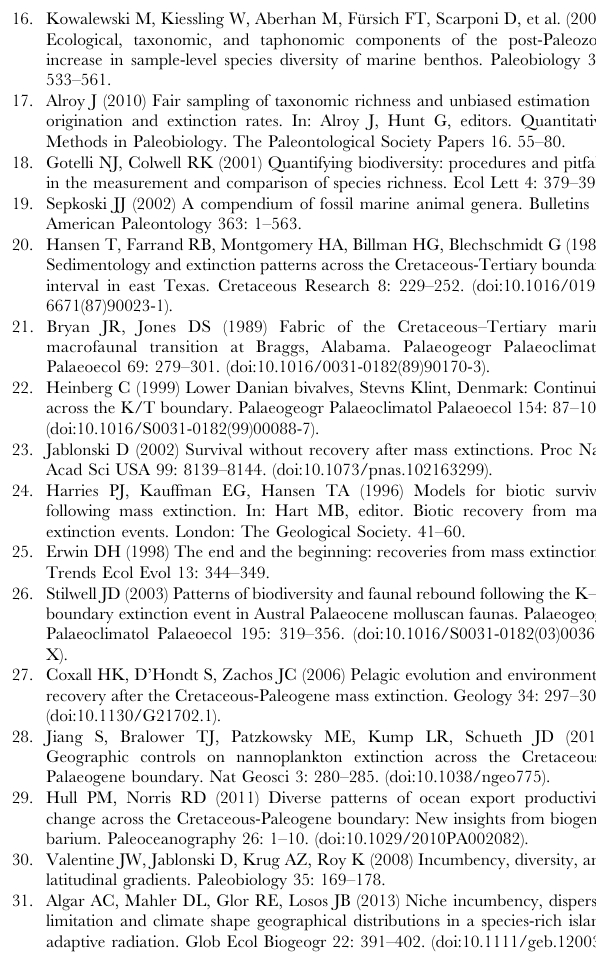
Table S1 Primary data of San Ramo´n. Table S2 Primary data of Bajada del Jagu¨el and